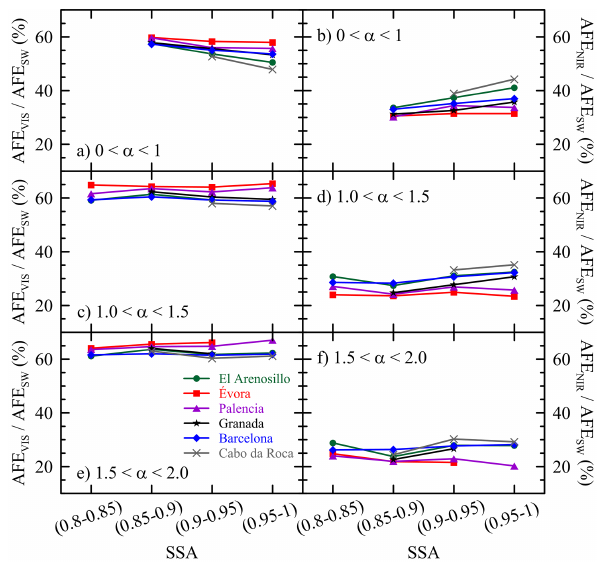
Figure 9. Dependence of AFE VIS /AFE SW (a, c, e) and AFE NIR /AFE SW (b, d, f) ratios on SSA for large, 0< α <1 (a, b) , medium, 1< α <1.5 (c, d) , and small, 1.5< α <2 (e, f) , particles at the six sites: Barcelona (blue diamonds), Palencia (purple triangles), Évora (red squares), Cabo da Roca (grey crosses), Granada (black stars), and El Arenosillo (green